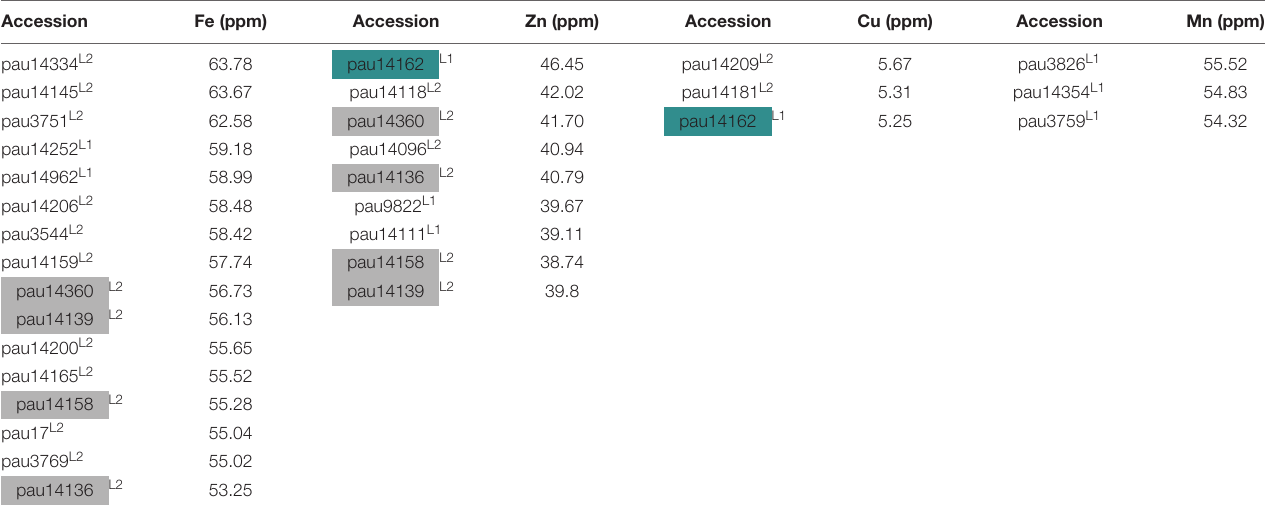
TABLE 2 | List of selected accessions of Ae. tauschii with high grain iron (Fe), zinc (Zn), copper (Cu), and manganese (Mn) concentrations. Accession Fe (ppm) Accession Zn